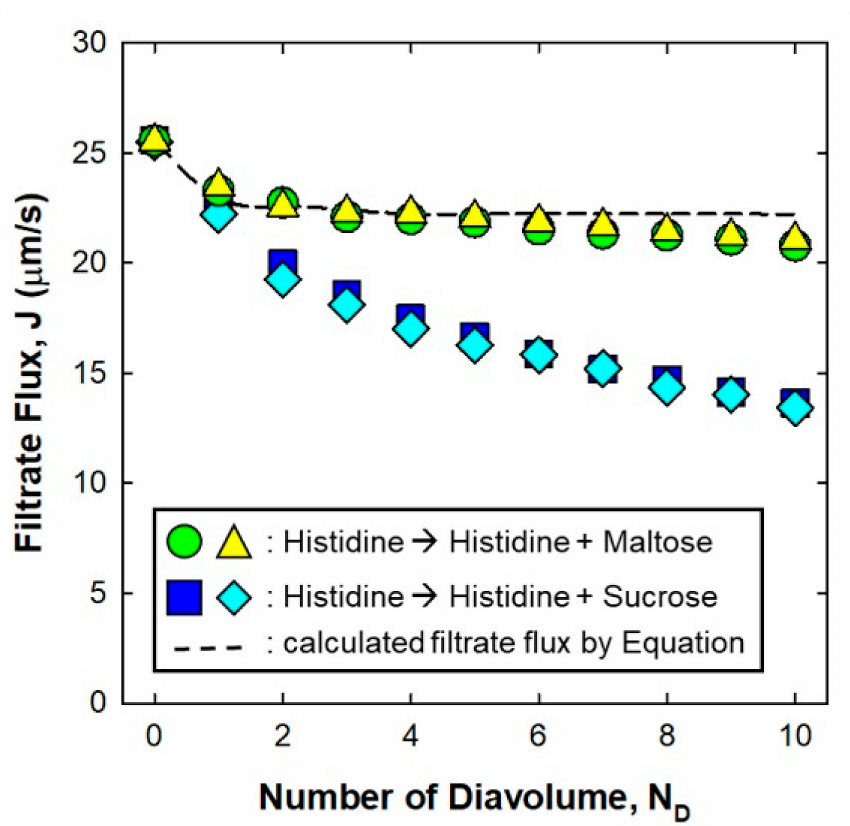
Figure 2. Experimental data for the filtrate flux as a function of the number of diavolumes (N D ) during diafiltration at a feed flux of 350 L/h/m 2 and a TMP of 140 kPa. The feed solution consisted of 7 g/L of IgG solution in 20 mM histidine buffer at pH 6. The diafiltration buffer was the feed solution that included 100 mM maltose or sucrose. The dashed curve represents the filtrate flux calculated by Equation (1).